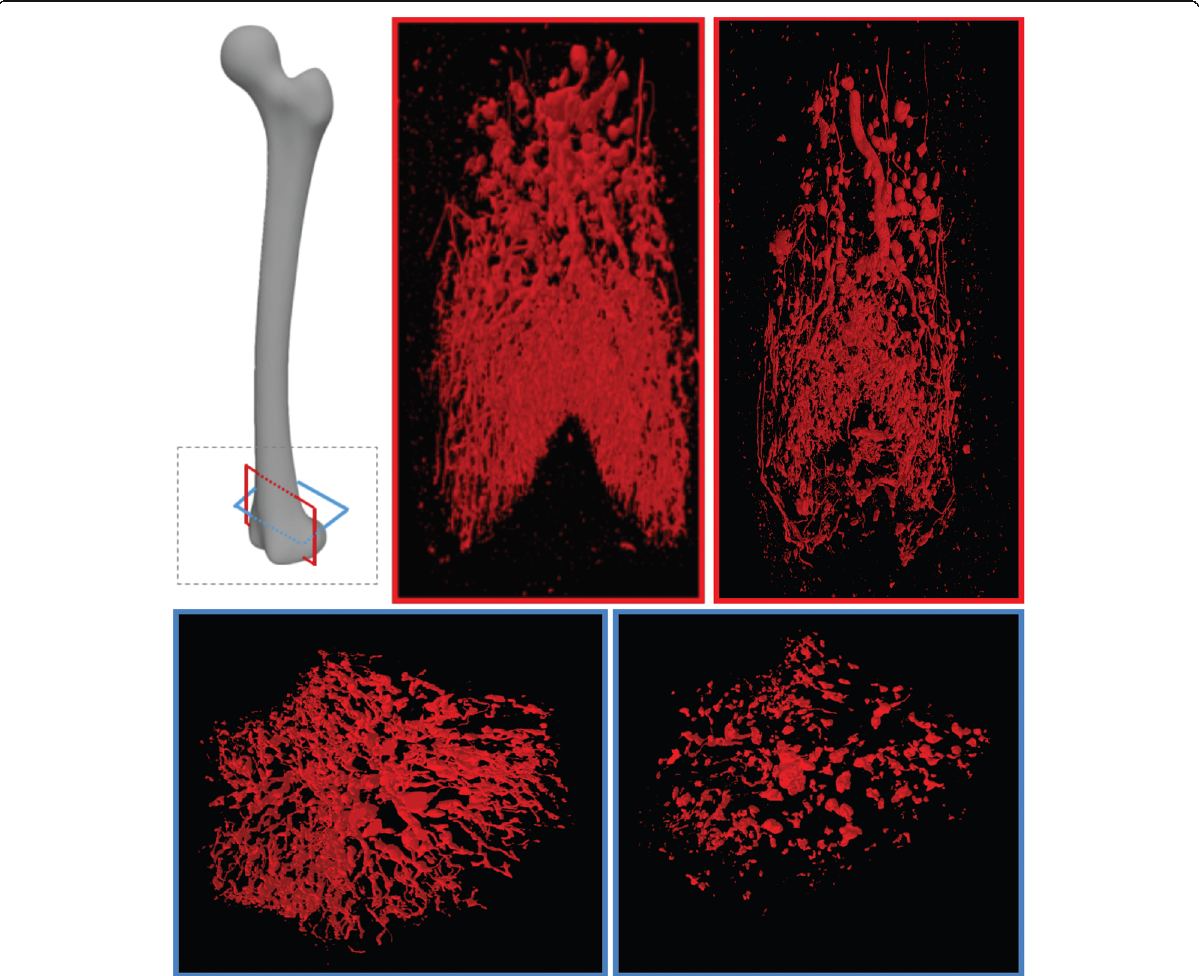
Fig. 4 Vascularisation of distal metaphysis of Zucker lean (ZL) rats and Zucker diabetic fatty (ZDF) rats, coronal and axial three-dimensional view. There was a lower vascular volume and number in ZDF rats as compared to ZL